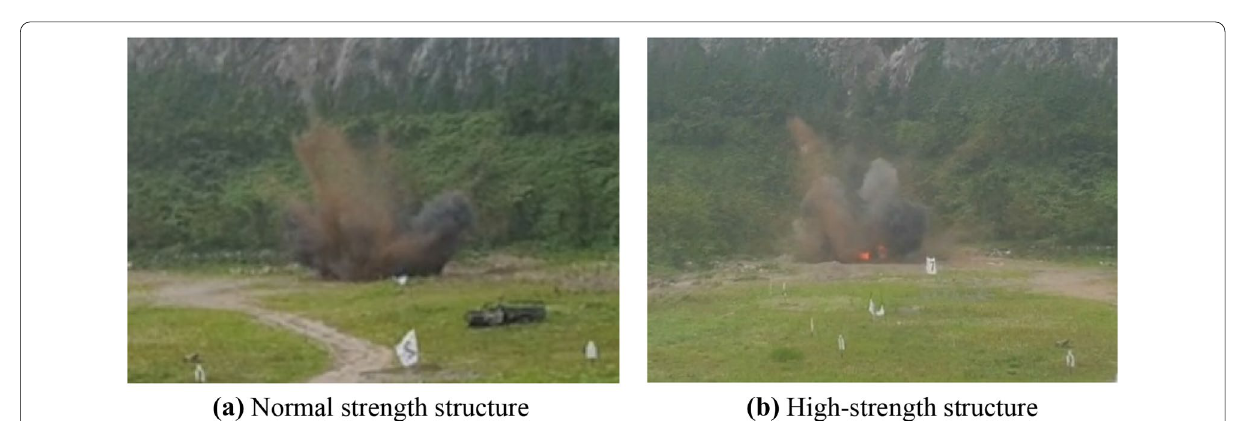
Fig. 12 Energy and fragment emission during explosion